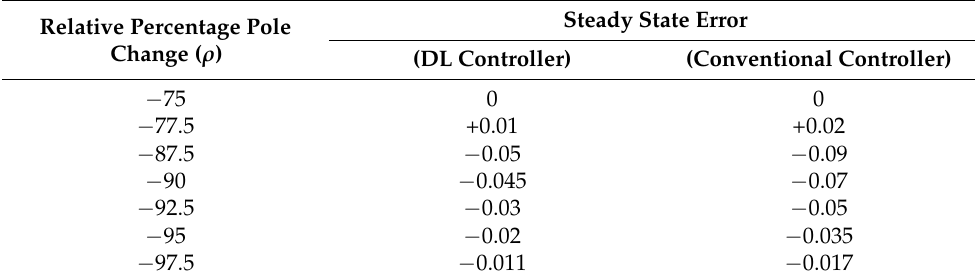
Table 3. Steady state error versus percentage pole change for different